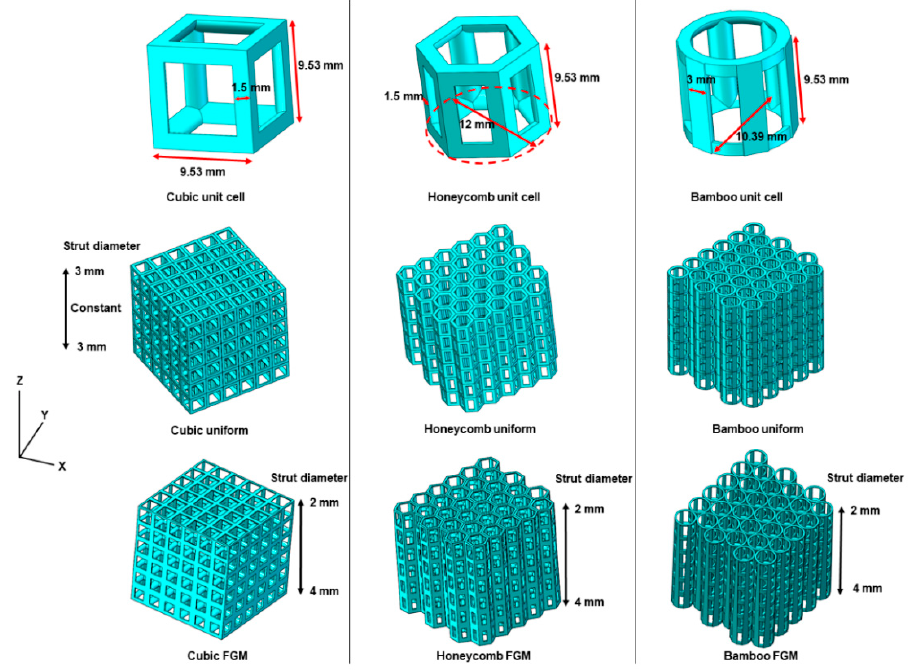
Figure 2. Design of uniform and FGM lattice structures in the building direction.